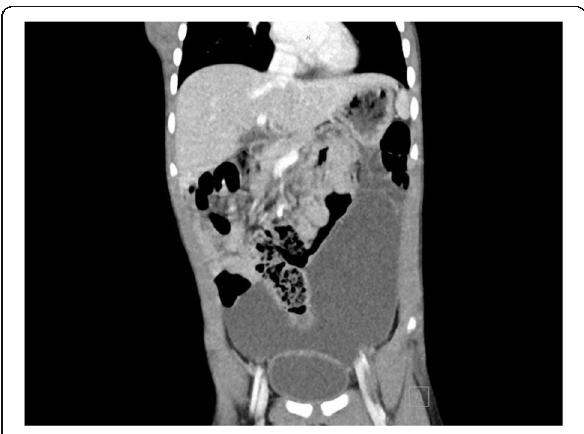
Fig. 1 Computed tomography of the abdomen demonstrated a 7.3 × 11.7 × 14.9-cm cystic mass originating from the greater curve of the stomach and reaching the dome of the bladder